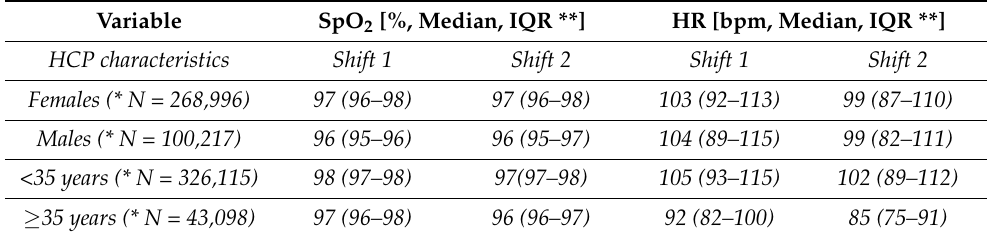
Table 1. Characteristics of SpO 2 and HR results by sex and age for shift 1 and shift